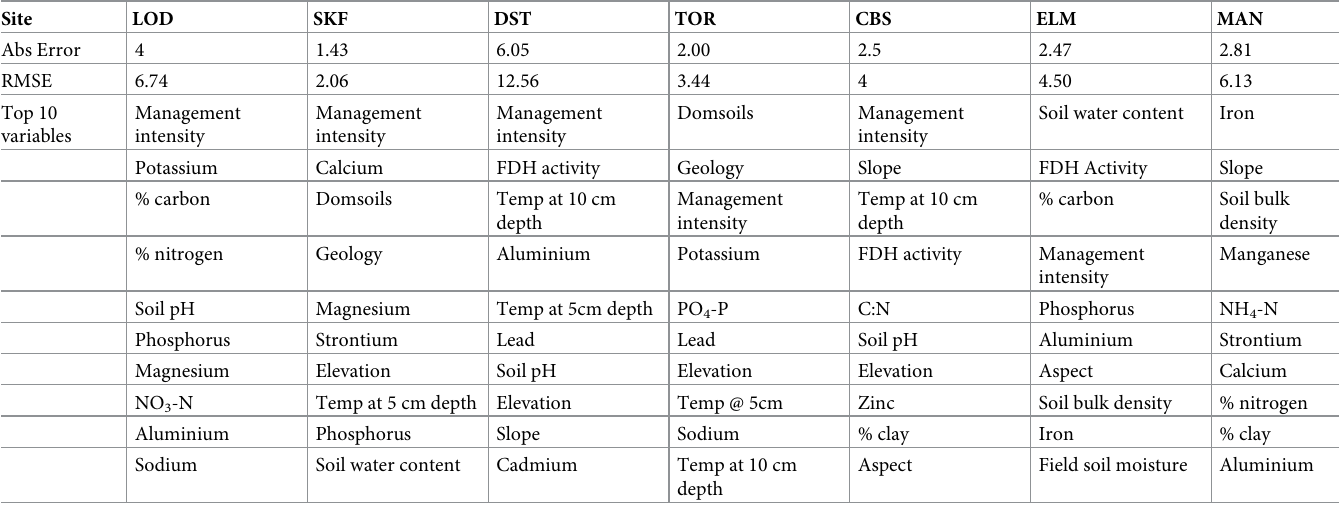
Table 2. Results from the Bayesian Belief Networks developed for each individual farm.